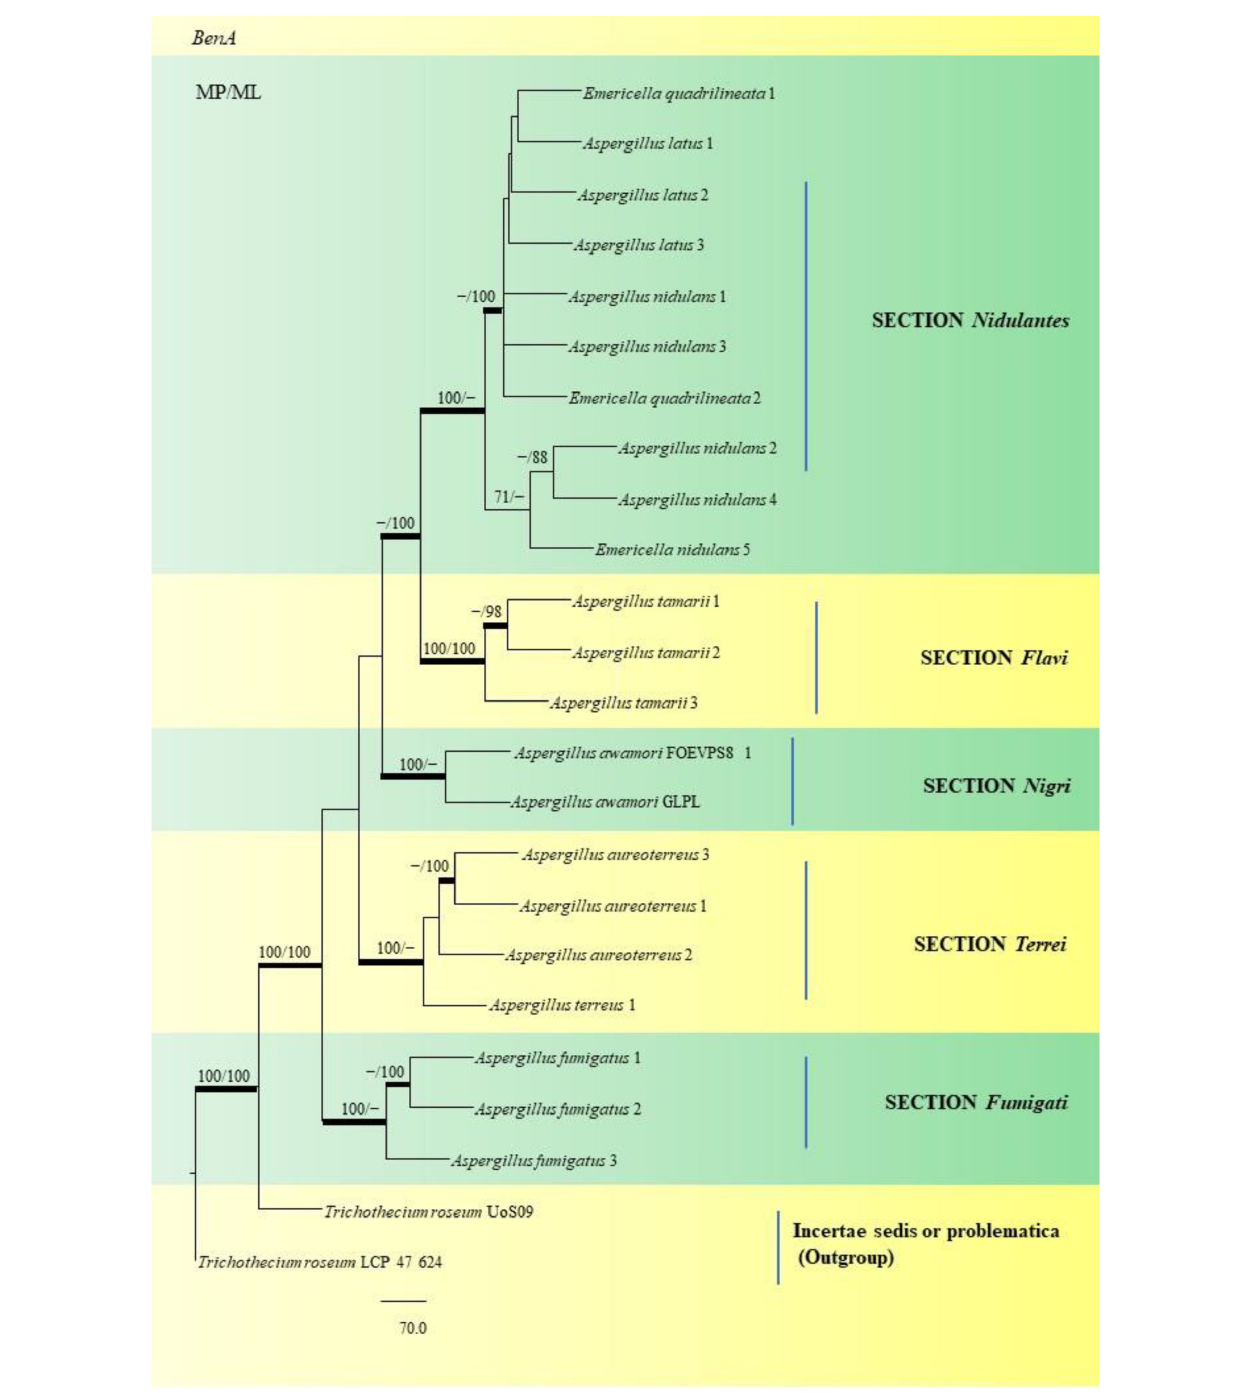
FIGURE 15 | This phylogram depicts the beta-tubulin phylogenetic tree of 22 Aspergillus species in sections, and subsequent analysis of their single nucleotide polymorphisms is discussed below. Maximum parsimony analysis was used to create this tree, which incorporates partial β -tubulin concatenated sequences. Boot strap (bs) values ≥ 70% are designated at the nodes for maximum parsimony (MP) and maximum likelihood (ML) methods; branches with values ≥ 95% bs are bold black. Hyphen (-) indicates support values below 70% for both parsimony and RAxML analyses. Trichothecium roseum Uo S09 and Trichothecium roseum LCP 47 624 were used to root the isolates. The Fungal Genetics and Mycotoxicology (FGM) laboratory codes for the isolates are listed here. 49: E. quadrilineata 1, 4: A. latus 1, 11: A. latus 2, 12: A. latus 3: 17: A. nidulans 1, 9: A. nidulans 3, 58: E. quadrilineata 2, 45: A. nidulans 2, 71: A. nidulans 4, 2: E. quadrilineata , 22: A. tamarii 1,